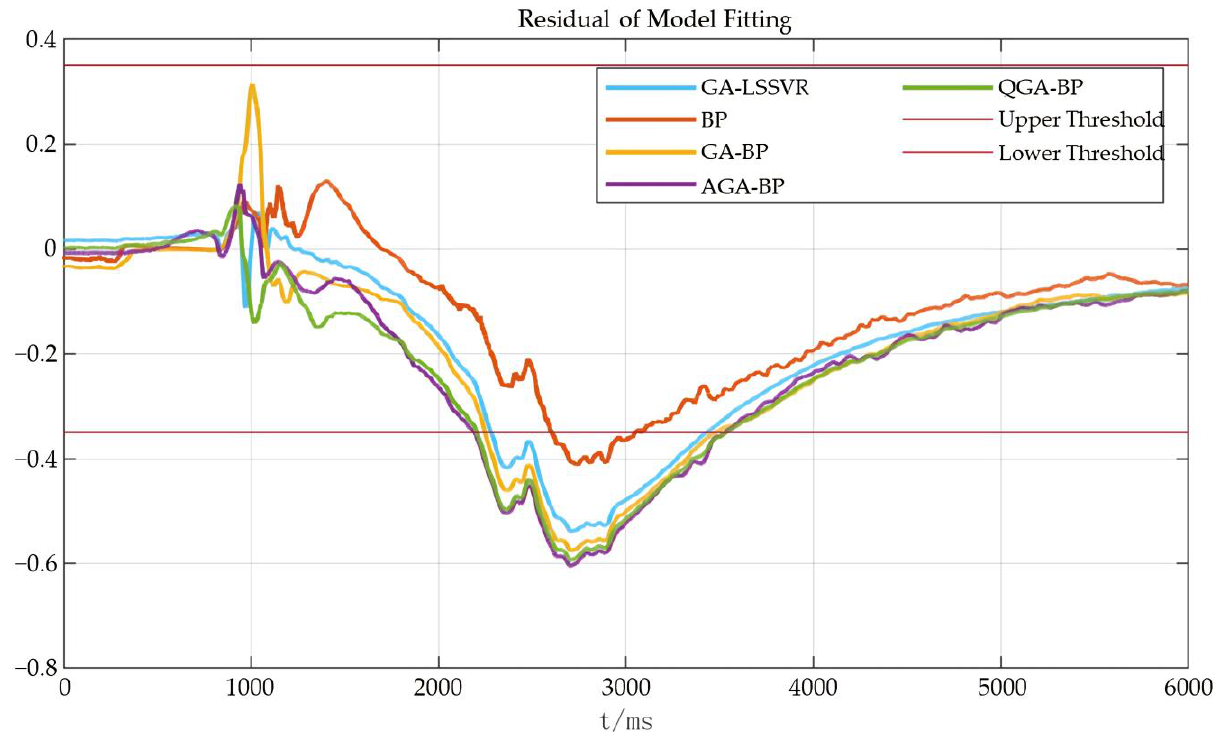
Figure 9. BP, GA-BP, AGA-BP, QGA-BP, GA-LSSVR fitting residual diagram: fault test data.